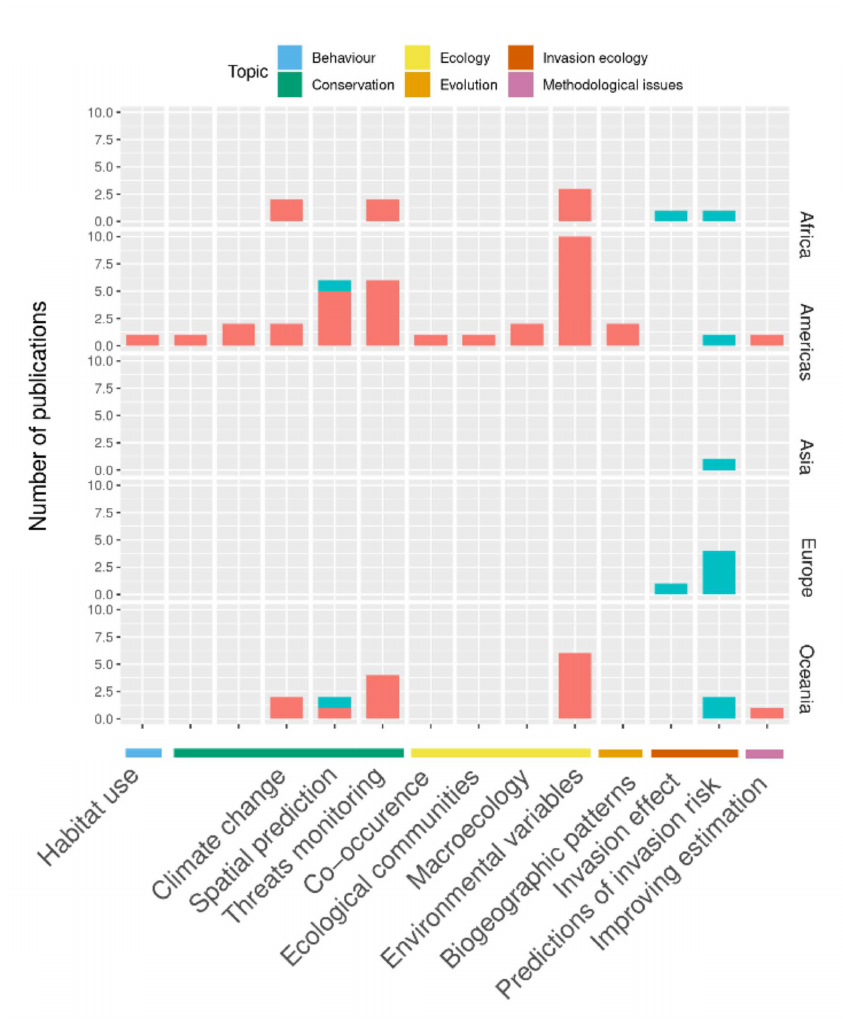
Figure 3. Geographical distribution of applications of the parrots’ distribution modelling. Number of published documents by region. Documents focused on native species are in red, whereas those focused on non-native species are in blue. Applications are grouped according to the main